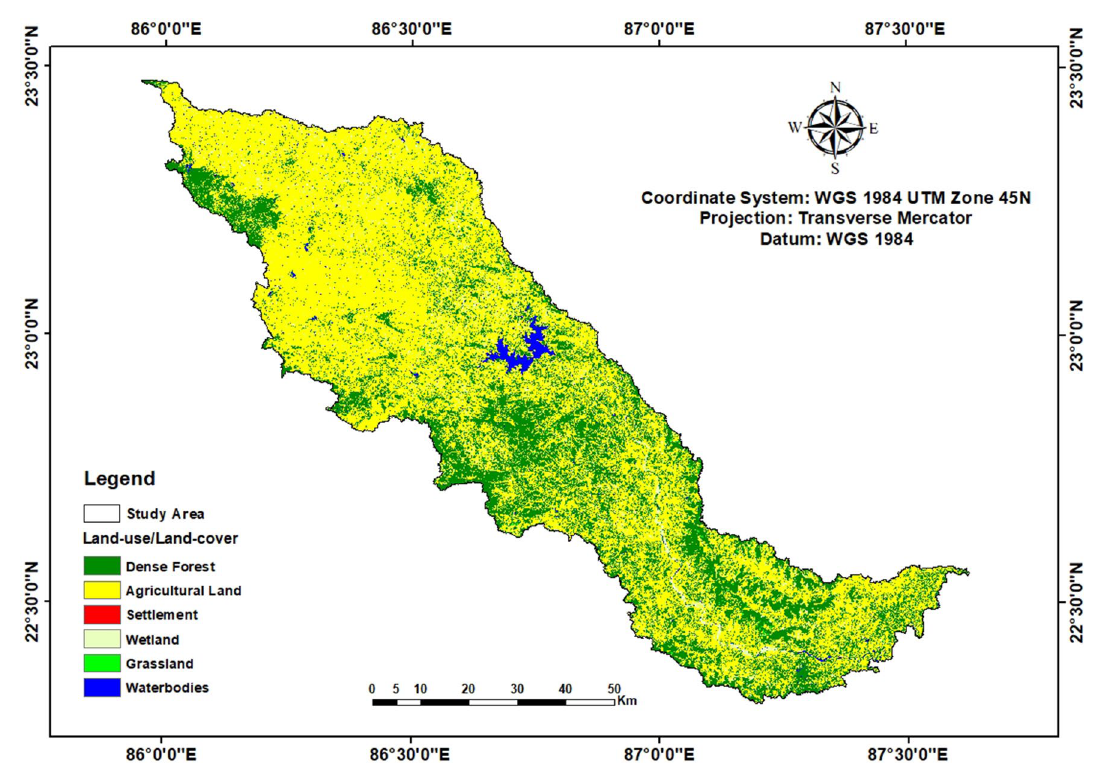
Fig. 8 Spatial map of land use/land cover in Kangsabati River